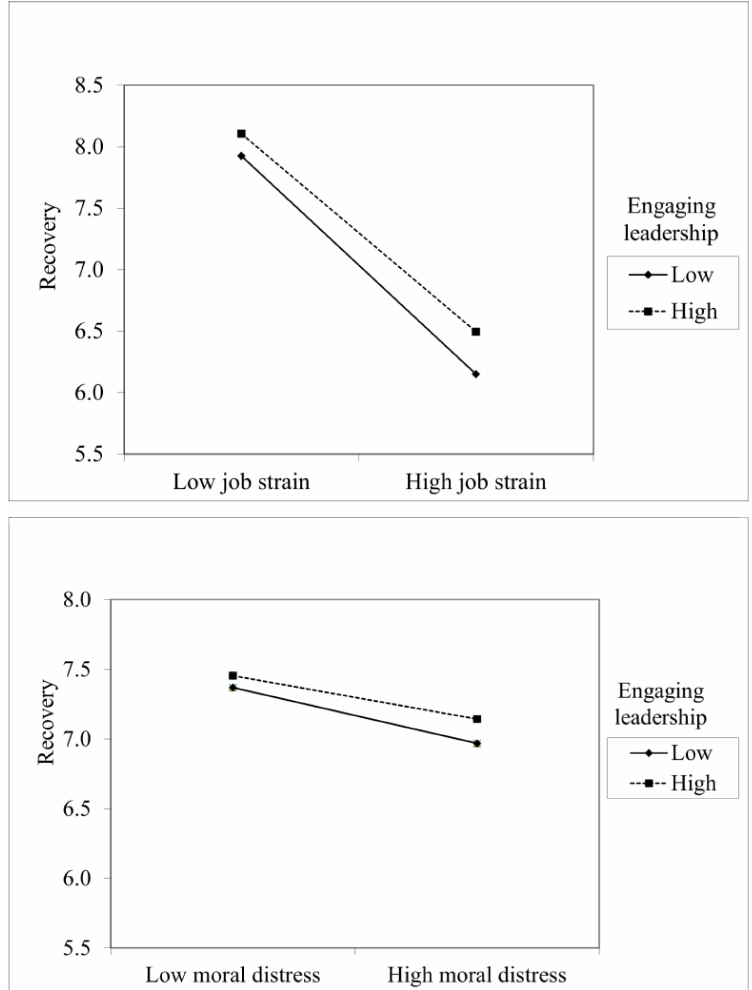
Figure 1. Engaging leadership moderates the effects of job strain and moral distress.